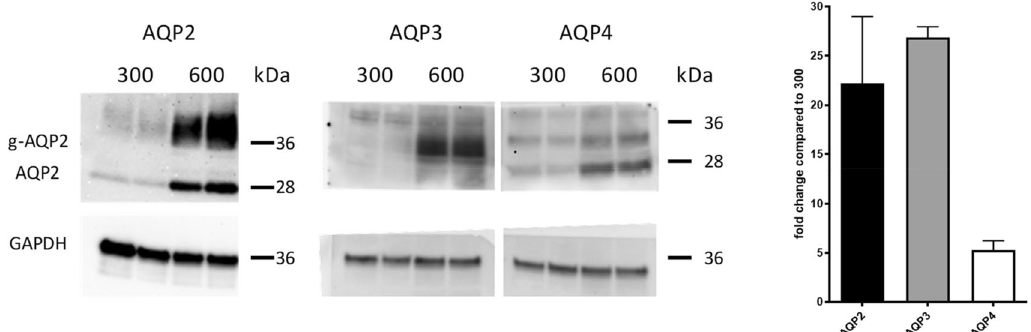
Figure 1. Protein expression of AQP2, AQP3 and AQP4 increases at higher osmolality. IMCD-cells have been cultivated in medium of 300 and 600 mosmol/kg. Proteins have been isolated and Western Blot was performed with antibodies directed against AQP2, AQP3, AQP4 and Glyceraldehyde 3-phosphate dehydrogenase (Gapdh). B: Densitometric analysis of AQP2, AQP3 and AQP4 protein level expression in cells cultivated at 600 mosmol/ kg (relative to 300 mosmol/kg). The membranes were cut before hybridization with the first antibody. After stripping of the first antibody the membranes were probed with an anti GAPGH antibody. All values are means ± SEM (n ≥ 2). Uncropped images are provided as Supplementary Fig. 1.